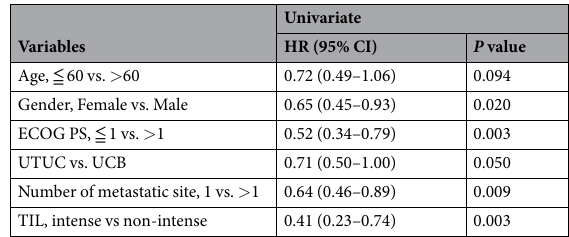
Table 3. Multivariate Cox regression analysis of parameters associated with overall survival. ECOG PS = Eastern Cooperative Oncology Group performance status, UTUC = upper tract urothelial carcinoma, UCB = urothelial carcinoma of bladder, PUC = pure urothelial carcinoma, VUC = variant urothelial carcinoma, TIL = tumor- infiltrating lymphocyte, HR = hazzard ratio, CI = confidence